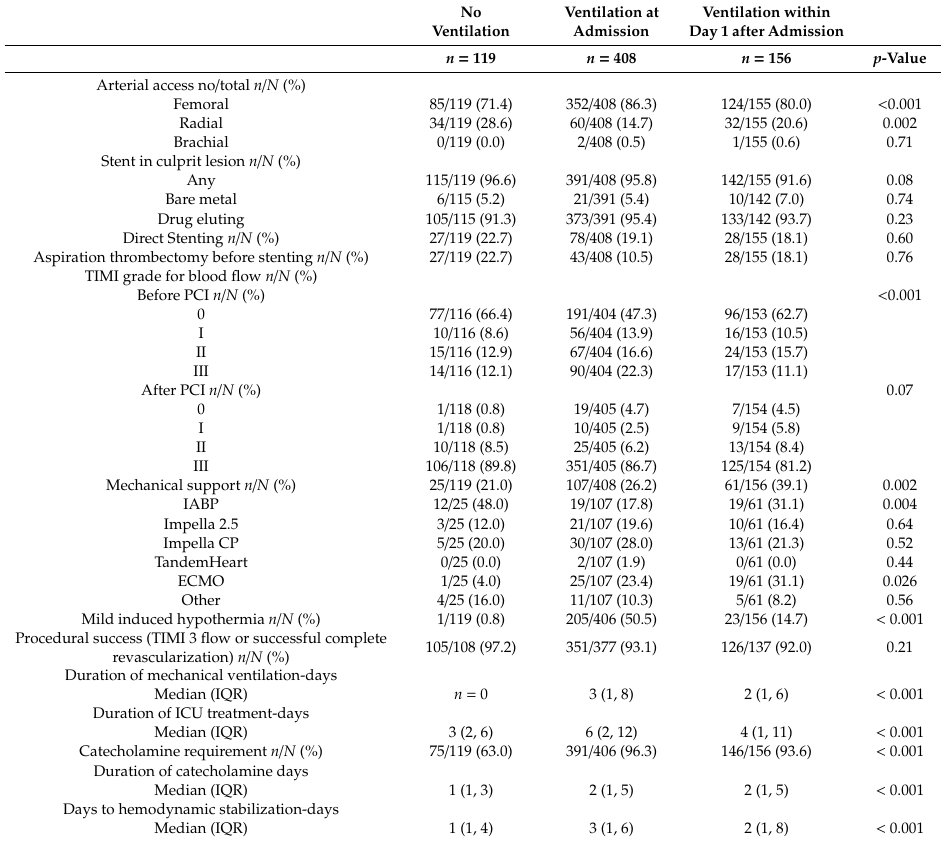
Table 2. Procedural characteristics.